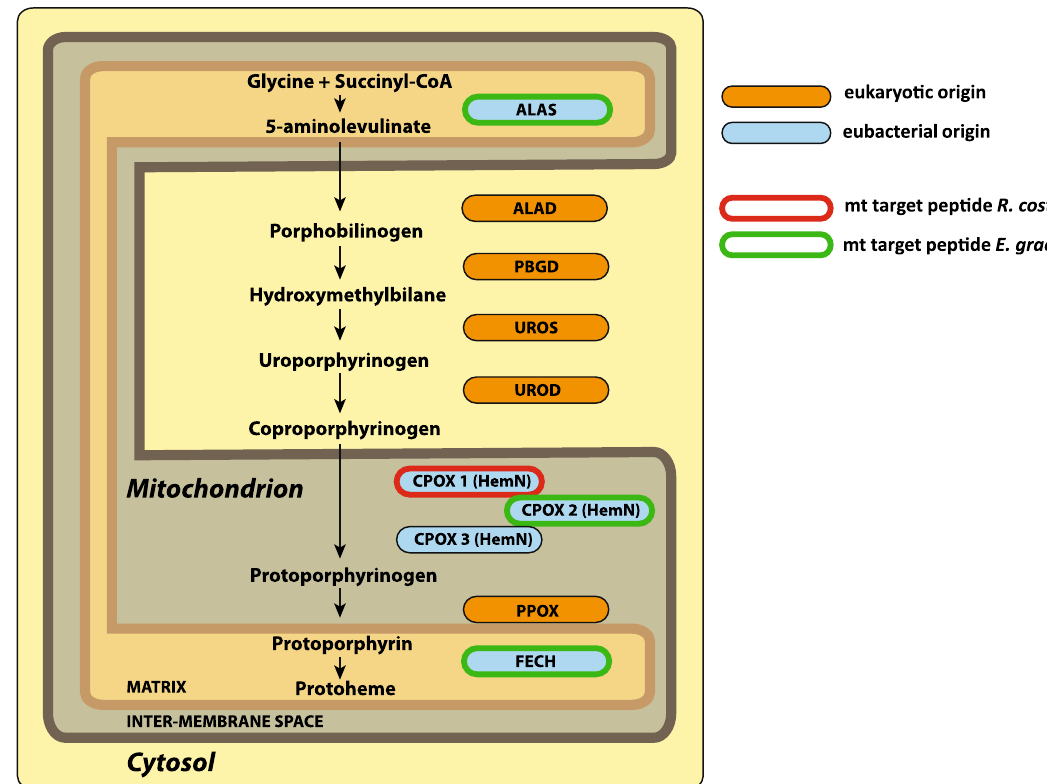
Figure 7. Origins and subcellular localisations of tetrapyrrole synthesis enzymes in R. costata . Predicted localisation of the enzyme is indicated by its position in the diagram. Phylogenetic origin is indicated by colour (orange—eukaryotic origin, blue—eubacterial origin). Presence of mitochondrial targeting peptide (TP) is indicated by frame (red frame—high TP value in R. costata , green frame—high TP value in